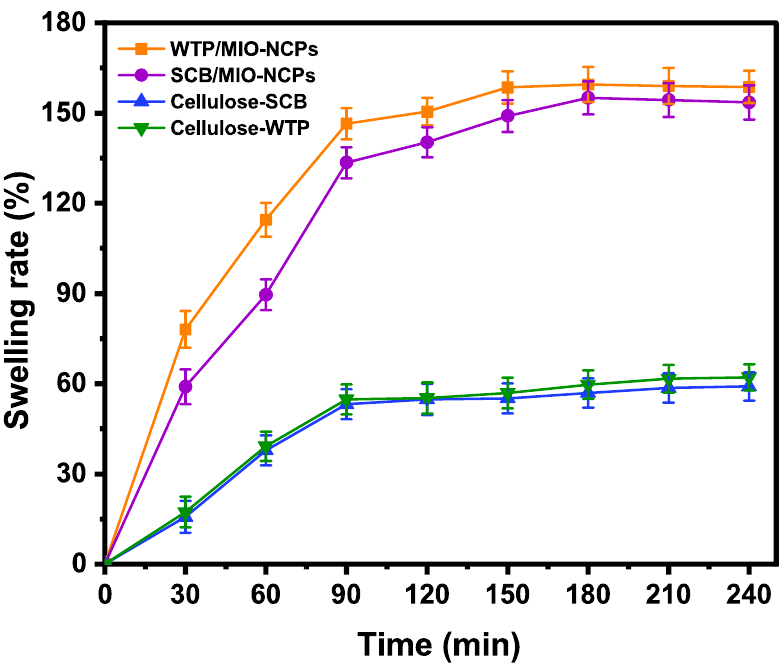
Figure 11. The swelling rates in cellulose-SCB, cellulose-WTP, WTP/MIO-NCPs, and SCB/MIO-NCPs.